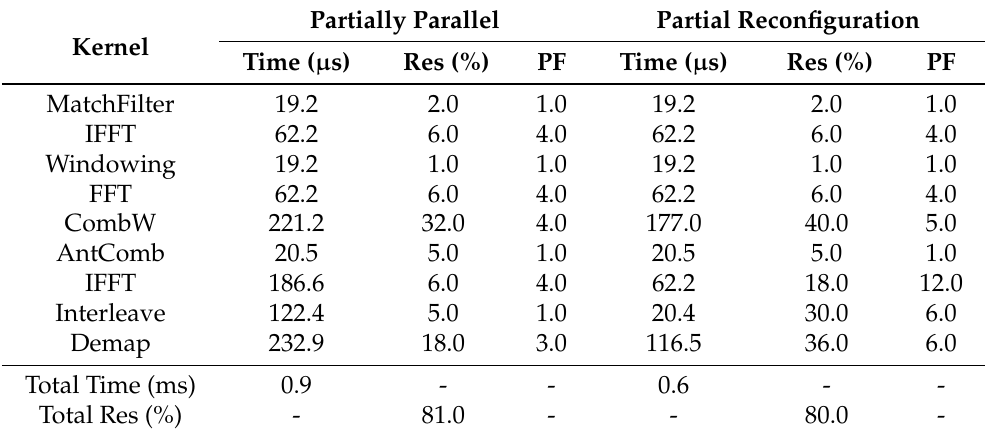
Table 5. The results of running an uplink application of PHY-Bench on XCZU3EG-SBVA484 FPGA for partially parallel and partial reconfiguration strategies when LAY = 2, ANT = 2, SC = 1200, SYM = 6, and MOD =